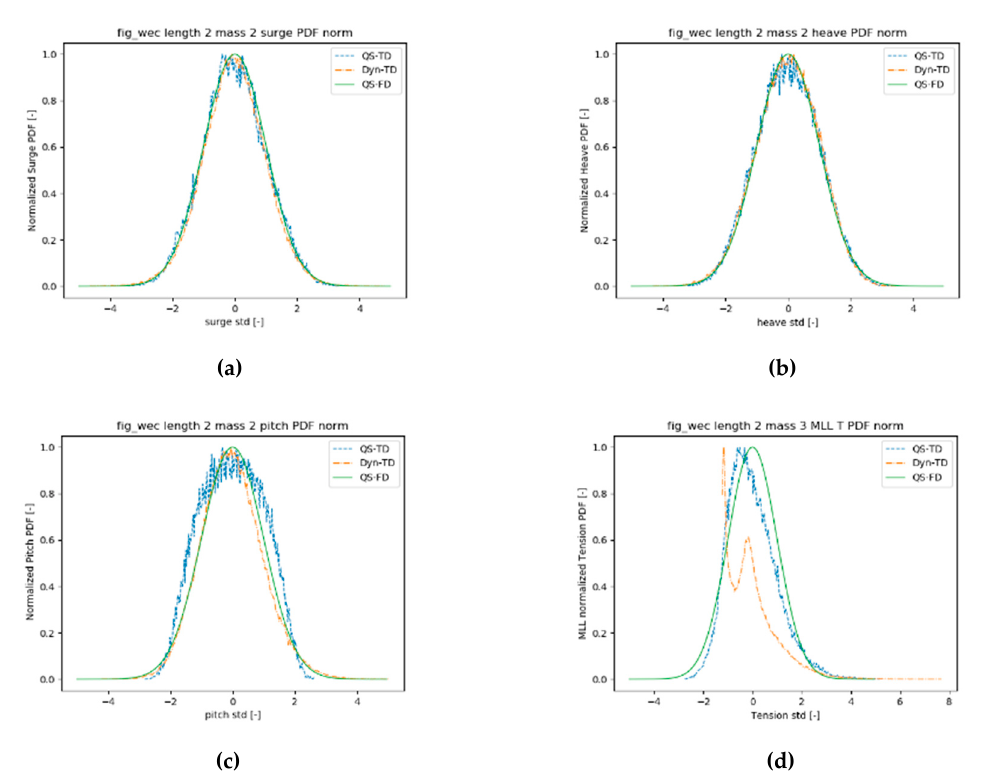
Figure 9. Normalized PDFs with the three models in surge (a) , heave (b) , pitch (c), and the most loaded line tension (d). Table 4. Mean obtained kurtosis and skewness of the FWEC motions and tension of the most loaded line, obtained with the QSTD approach